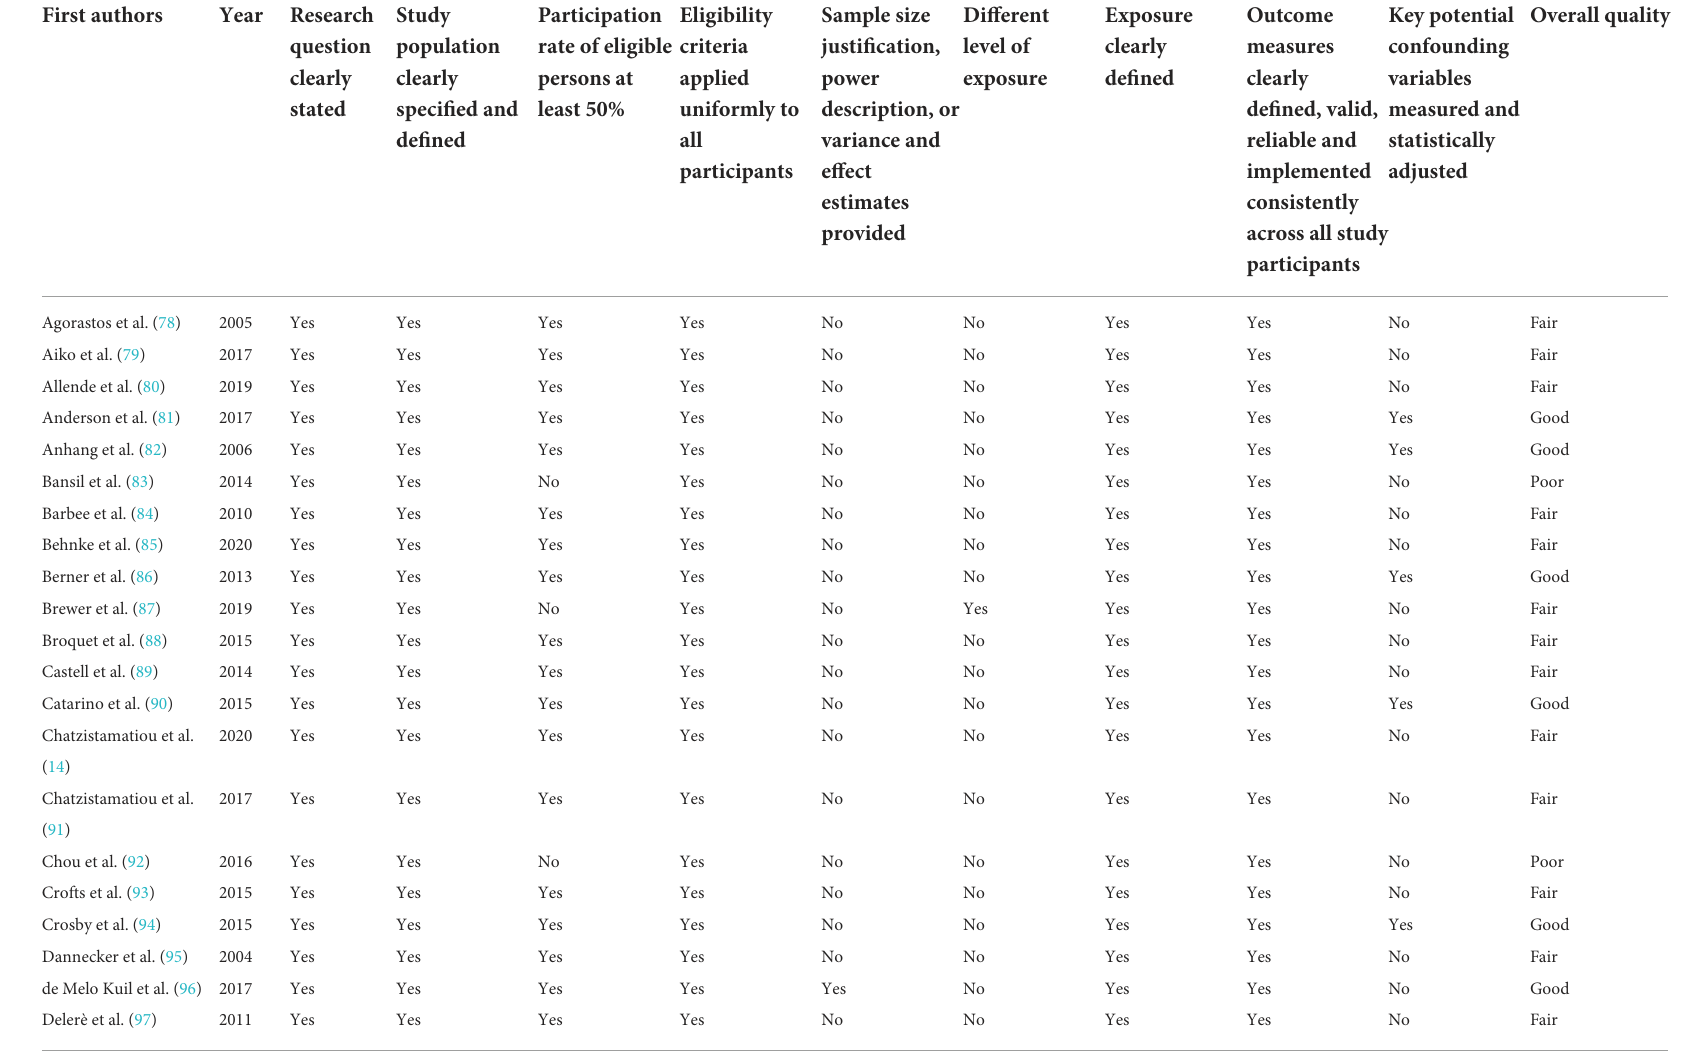
TABLE 2 Risk of bias of included observational studies assessed by NIH Quality assessment tool for observational cohort and cross-sectional